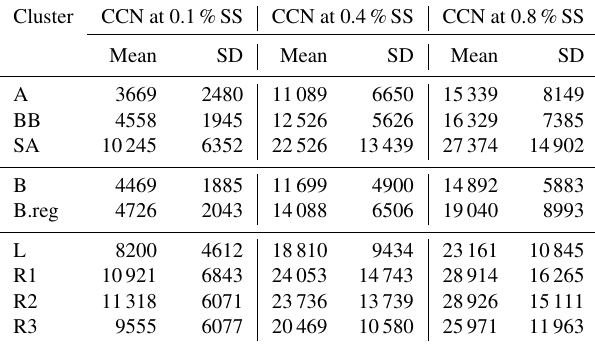
Table 3. Mean values of CCN number concentrations (cm − 3 ) at 0.1%, 0.4%, and 0.8% SS for all